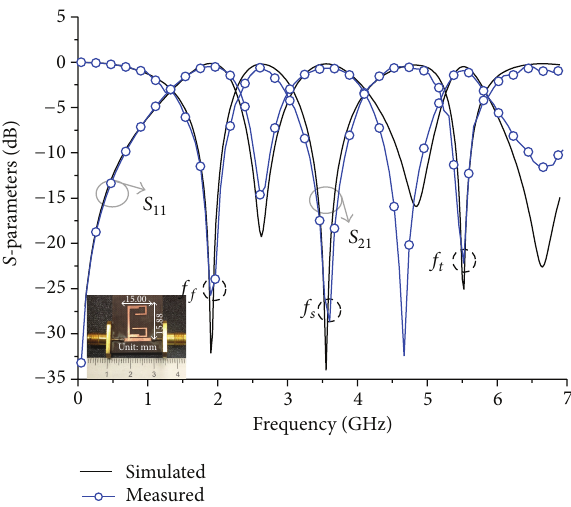
Figure 10: Photograph of the fabricated TBBSF (15mm × 15.88 mm) and results of order 𝑁 = 1